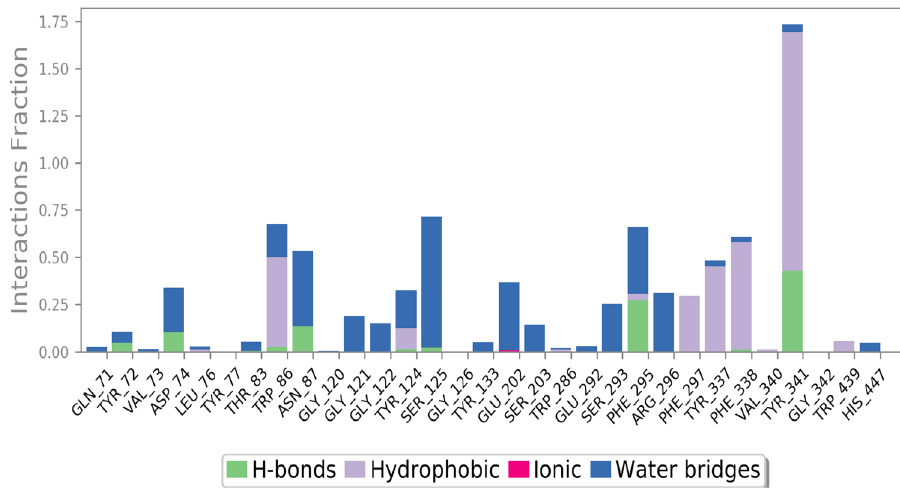
Figure 13. Protein–ligand contacts during the MD run.